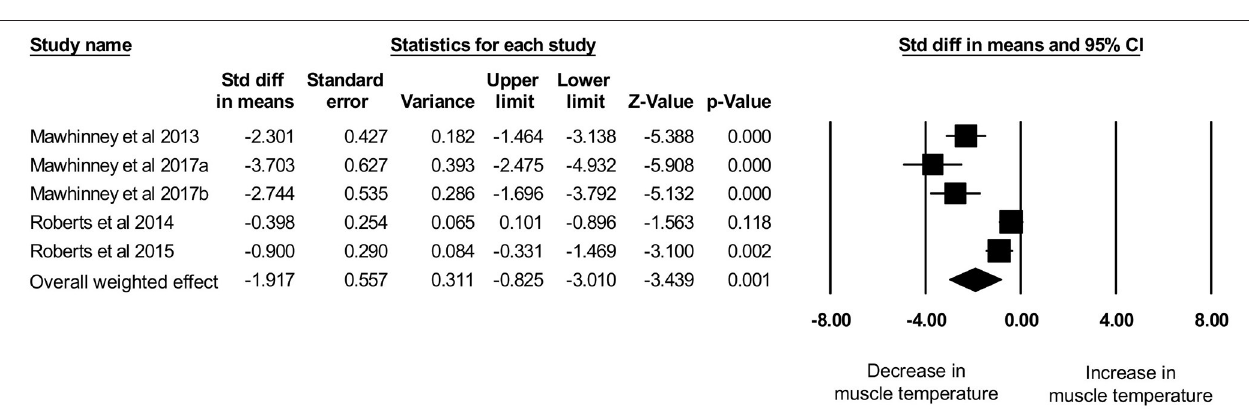
FIGURE 5 | Forest plot of the meta-analysis illustrating the comparison between baseline and post-exercise CWI temperature values at a muscle depth of